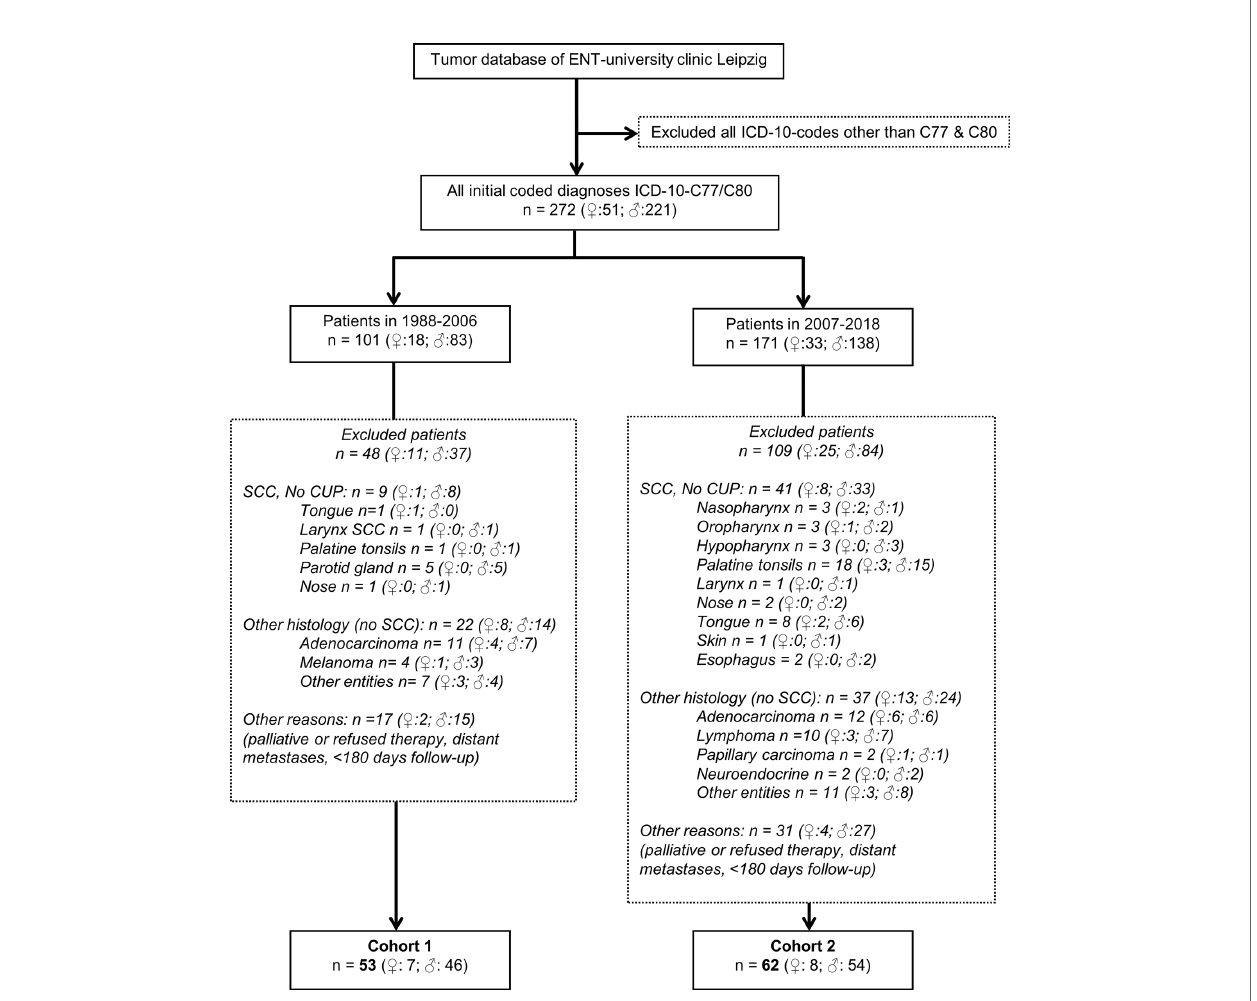
FIGURE 1 | CONSORT diagram showing the selection criteria of neck squamous cell carcinoma of unknown primary (NSCCUP) patients of the two cohorts before and after standardization of diagnostic workup and therapy as well as the distribution of primary tumors detected leading to exclusion of initially suspect NSCCUP